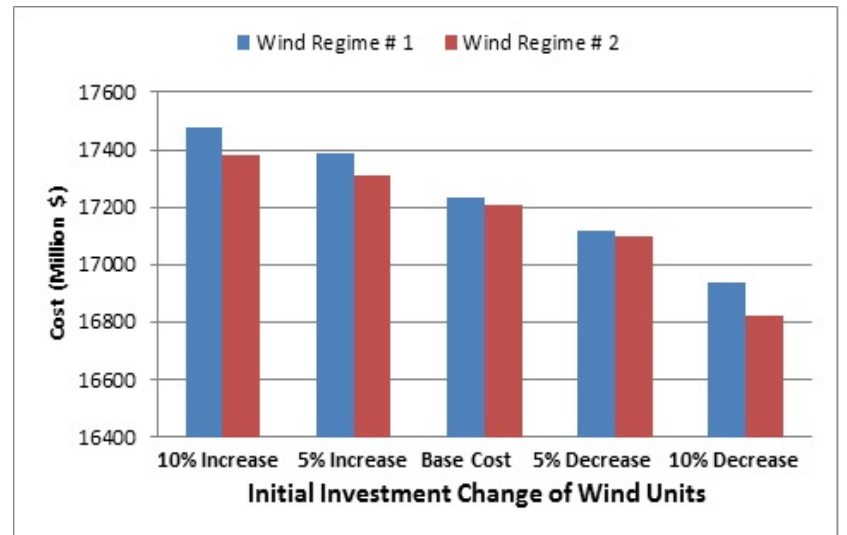
Figure 7. The impact of reduced wind unit investment on the objective function.